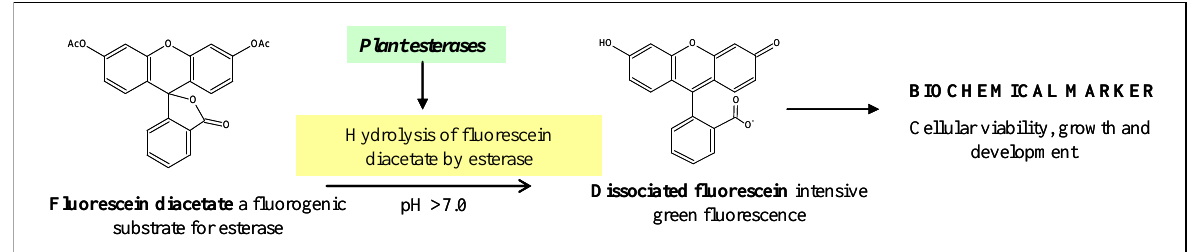
Figure 1. Reaction scheme of fluorescein diacetate hydrolysis catalyzed by plant esterases